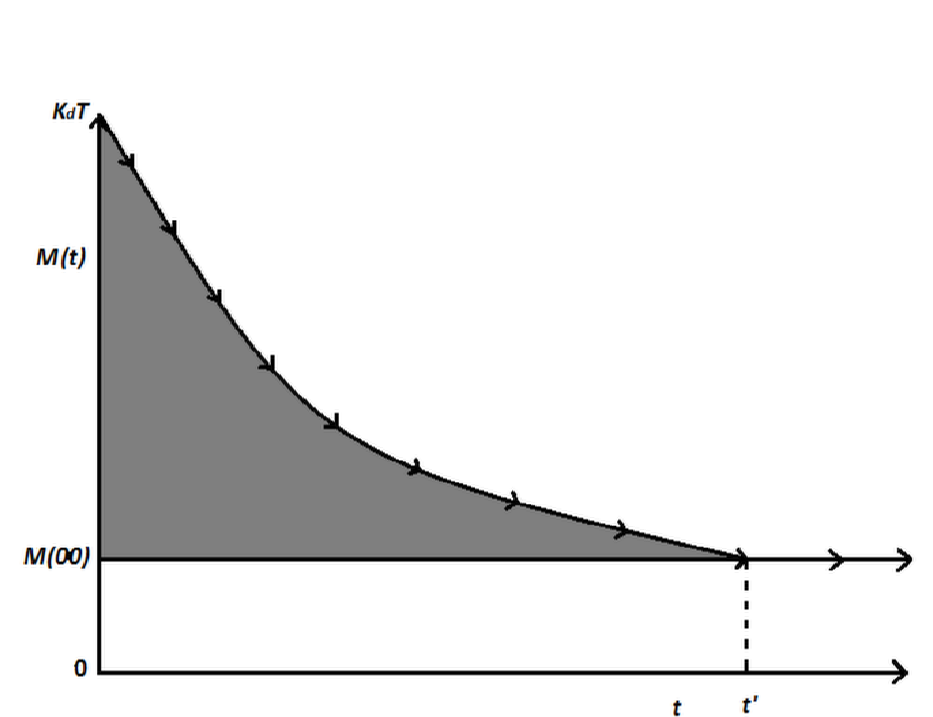
Figure 3 . Dynamic efficiency loss because of a quantity